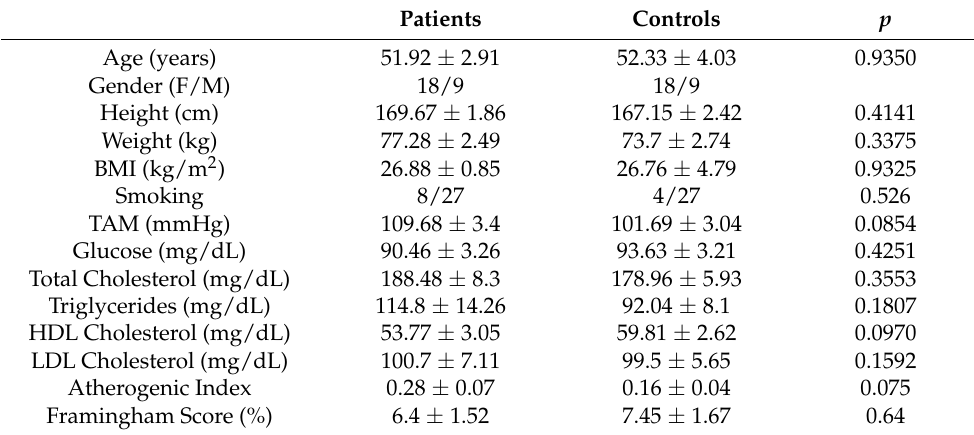
Table 1. Demographic and laboratory measurements of study population (mean ±